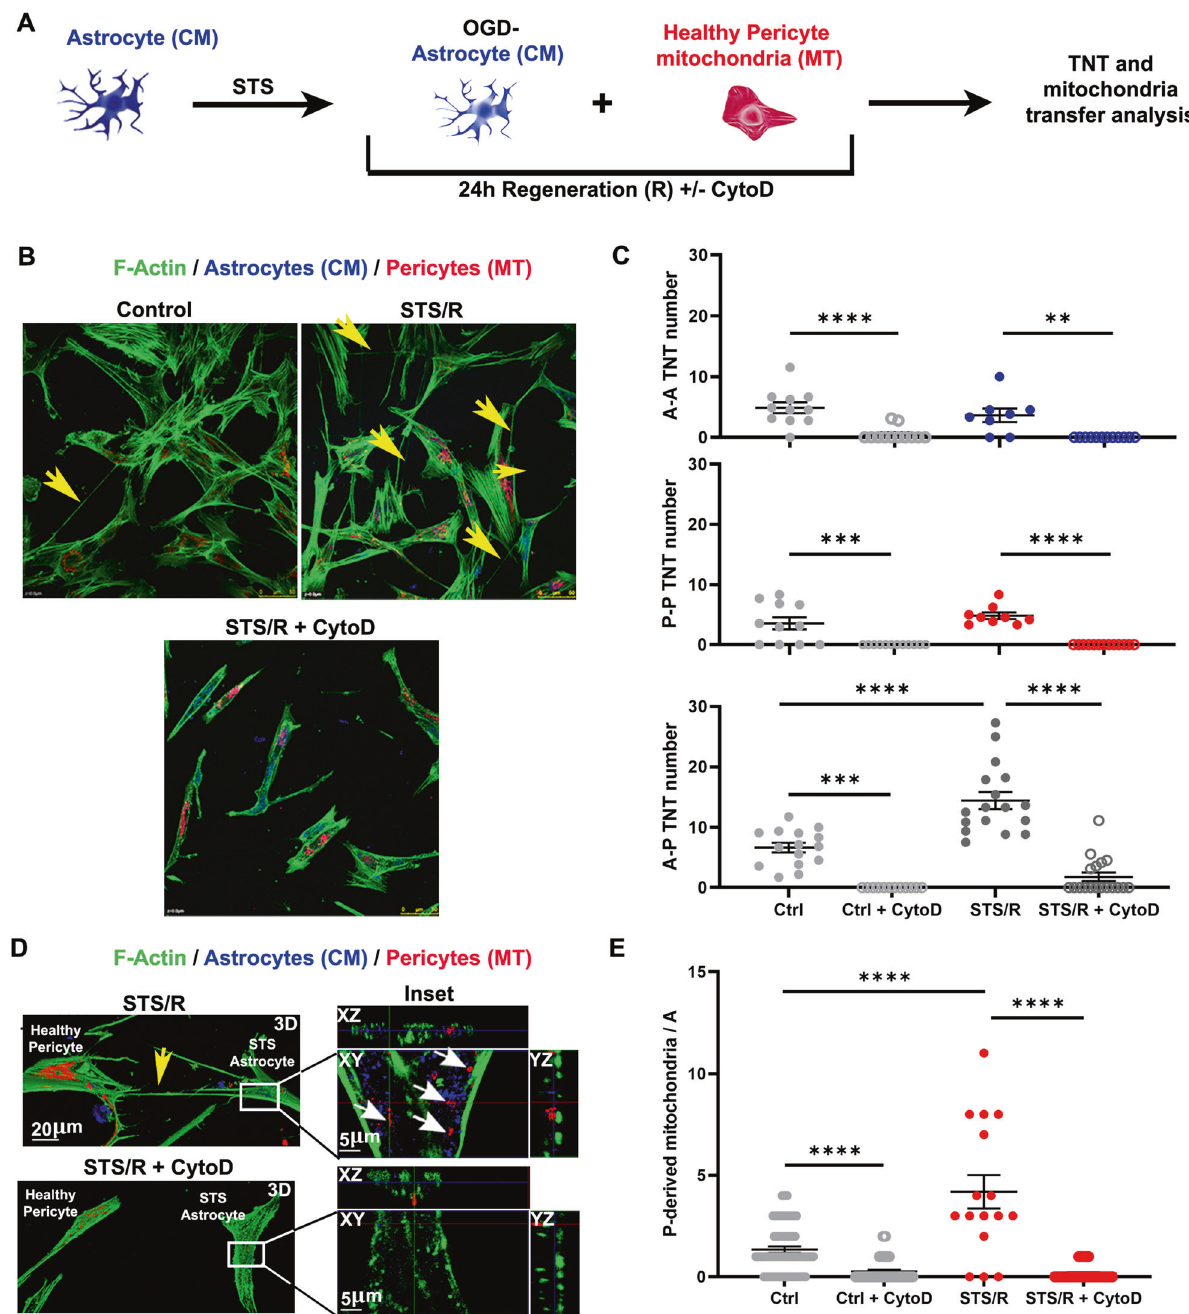
Fig. 6 Staurosporin treatment of astrocytes triggers TNT formation with healthy pericytes in a cytoskeleton-dependent manner. A CM- labeled astrocytes (blue) were treated with STS (1 μ M for 3 h), washed, and co-cultured with pericyte that had been previously stained with MT (red) (STS/R) with or without CytoD (STS/R + CytoD). After 24 h, cells were fi xed, stained for the F-actin-network with phallodin (green), and analyzed by confocal microscopy for the TNT number and mitochondria transfer. B STS-astrocytes trigger TNT heterotypic-TNT formation with healthy pericytes. Astrocyte-to-pericyte TNT (yellow arrows) are indicated in control and in STS/R. Note that STS/R trigger TNT while CytoD completely prevents TNT formation. Homotypic (A-A and P-P) and heterotypic (A-P) TNT were counted between control or STS-astrocytes and pericytes (STS/R) in the absence or in the presence of CytoD (STS/R + CytoD). C Quantitative evaluation of the astrocyte-astrocyte (A-A), pericyte-pericyte (P-P) and heterotypic astrocyte-pericyte (A-P) number of TNT after 24 h of co-culture. STS-astrocytes strongly upregulate heterotypic-TNT formation, an effect that is strongly inhibited by CytoD treatment. D 3D confocal reconstruction at higher magni fi cation of the experiments shown in D. XY plane and relative Z-projections show a representative [STS/R astrocytes + pericytes] co-culture incubated in the absence (up ) or presence ( bottom ) of CytoD. TNT between STS/R astrocytes and pericytes are indicated by the yellow arrows; pericyte- derived mitochondria are indicated by the white arrows. Note that CytoD treatment prevents the formation of TNT and strongly reduces mitochondria transfer from pericytes to astrocytes. Images are representative of N = 4 independent experiments. E Quanti fi cation of pericyte- to-astrocytes mitochondria transfer. N = 3; ** p < 0.005, *** p < 0.001, **** p < 0.0001, two-way ANOVA/Tukey ’ s tests.